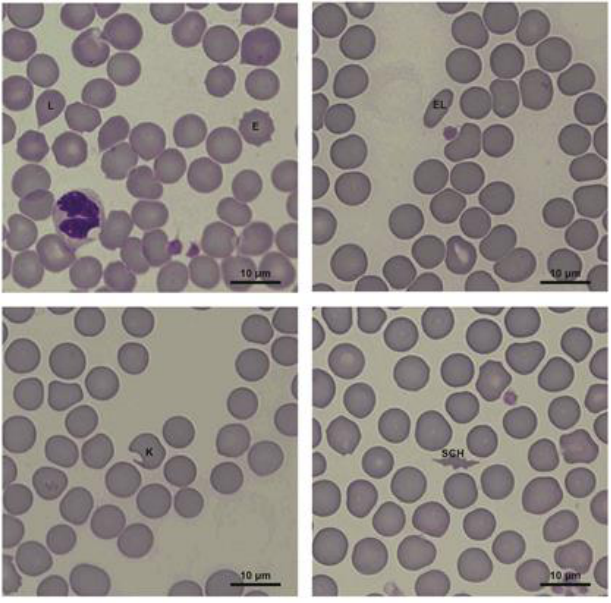
Figure 1. Erythrocyte morphology changes in bitches (E — echinocyte, EL — elliptocyte, K — keratocyte, L — lacrimocyte, SCH — schistocyte).